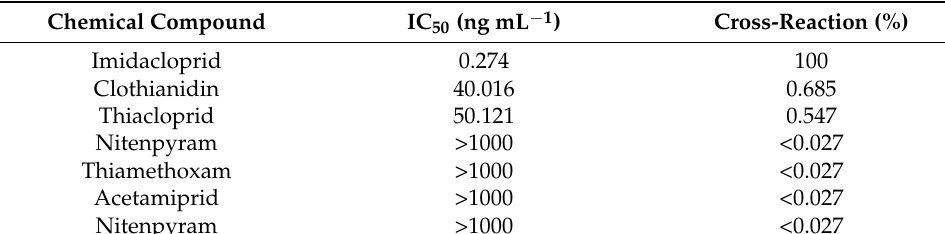
Table 1. Results of cross-reactivity using imidacloprid mAb. Chemical Compound